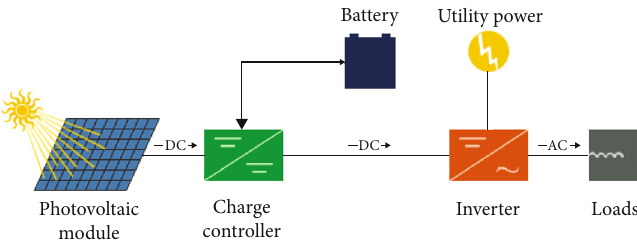
Figure 1: Schematic diagram of the on-grid photovoltaic system